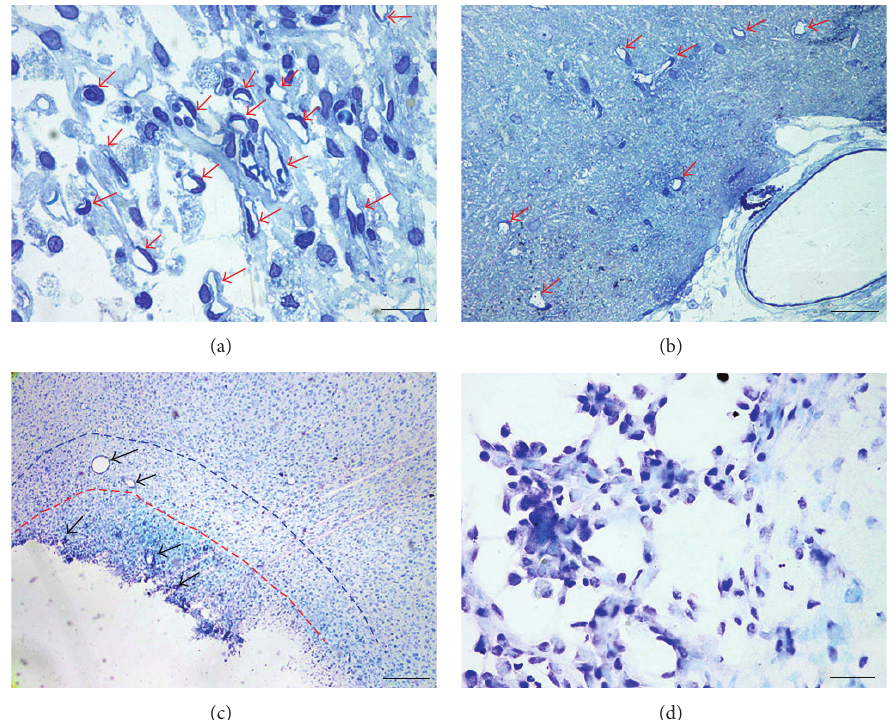
Figure 7: Morphological characteristics of group 5. (a) Group 5. Infiltrate. Newly formed vessels and macrophages. The vessels are marked with arrows. Semi-thin section. (b) Group 5. Penumbra. Newly generated vessels are marked with arrows. Semi-thin section. (c) Group 5. Damaged area. Newly generated vessels with a large diameter are observed in the infiltrate and penumbra. The vessels are marked with black arrows; the red dashed line bounds the infiltration zone, and the blue line denotes the penumbra. (d) Group 5. Infiltration. Small number of macrophages with green granules. The scale bars are 20 𝜇 m in (a) and (d), 100 𝜇 m in (b), and 300 𝜇 m in (c).